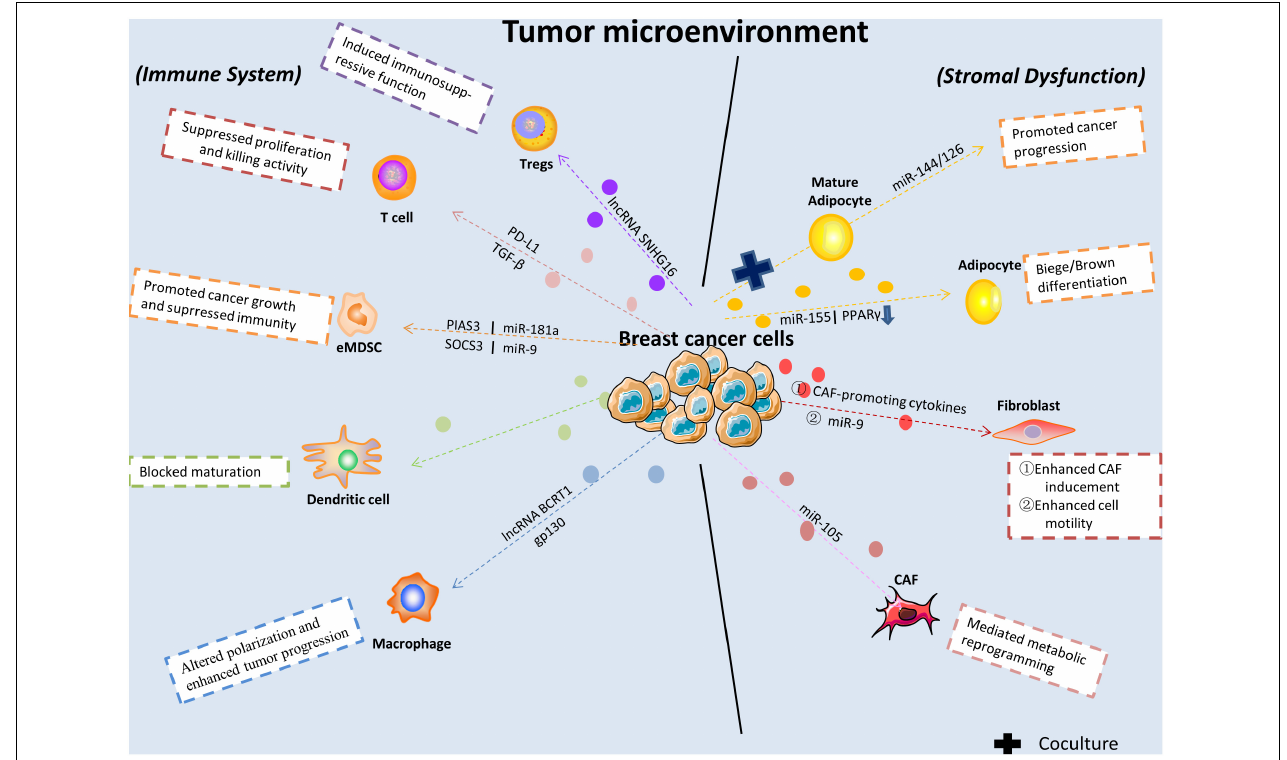
FIGURE 1 | Breast cancer-released exosomes in regulating immune system, fibroblasts, and adipocytes in tumor microenvironment. BC-derived exosomes are released to alter immune system and cause stromal cell dysfunction in tumor microenvironment via transferring multifarious cargos and targeting genes or signaling pathways. eMDSC, early-stage myeloid-derived suppressor cells; CAF, cancer associated-fibroblast; Tregs, regulatory T